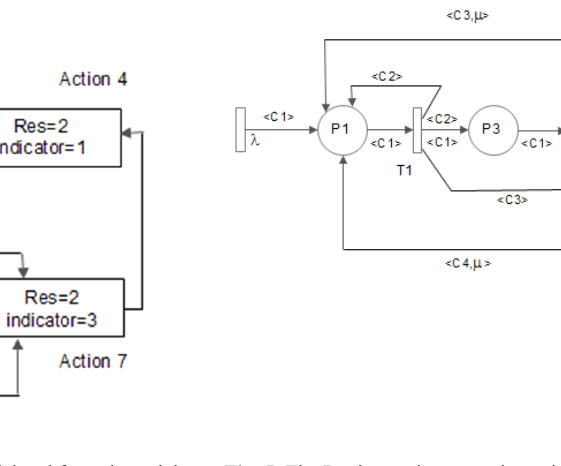
Fig. 4. The middle graph between real model and formal model Fig. 5. The Petri net relevant to the action Diagram